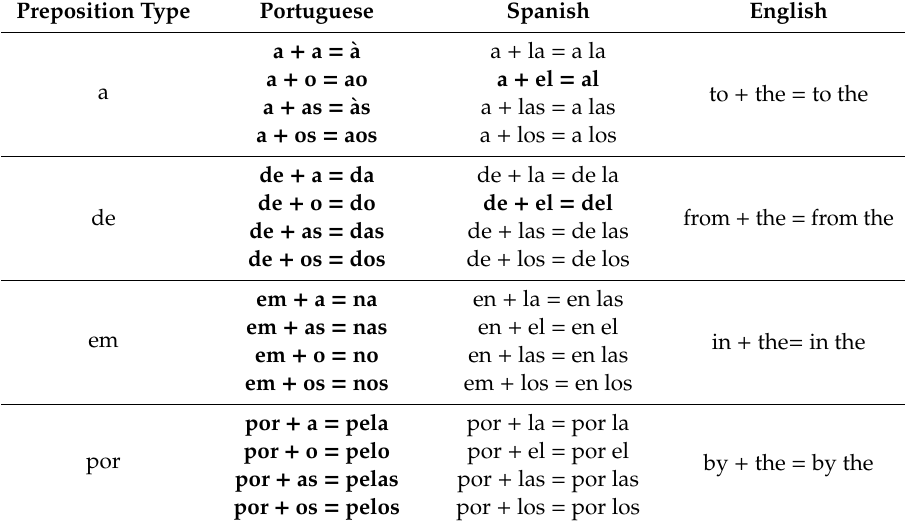
Table 1. Target preposition + definite article contractions that are obligatory in Portuguese, showing no contractions in English and two instances of contractions in Spanish (i.e., del and al).